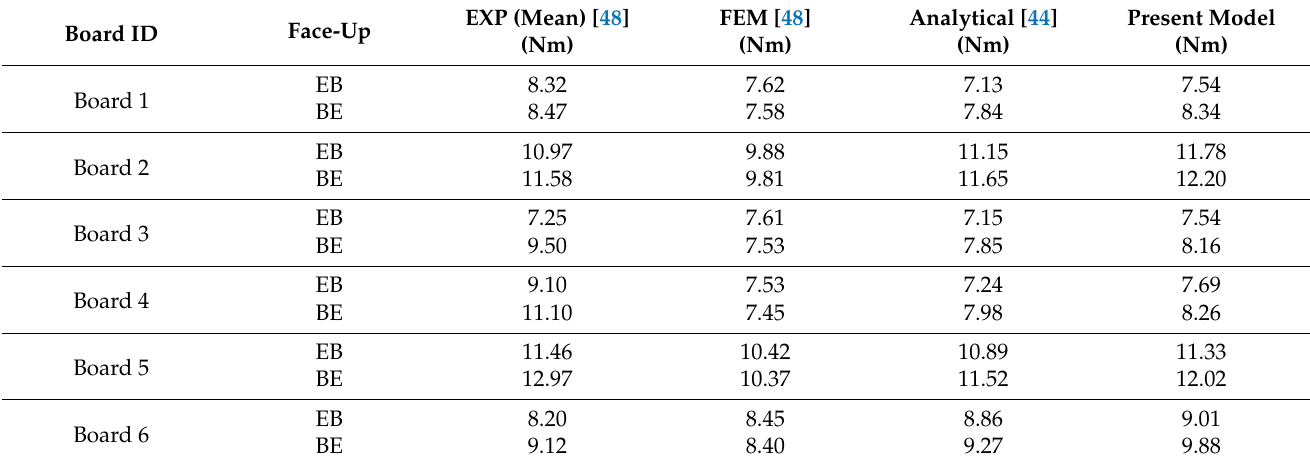
Table 12. Bending stiffness in MD for all considered